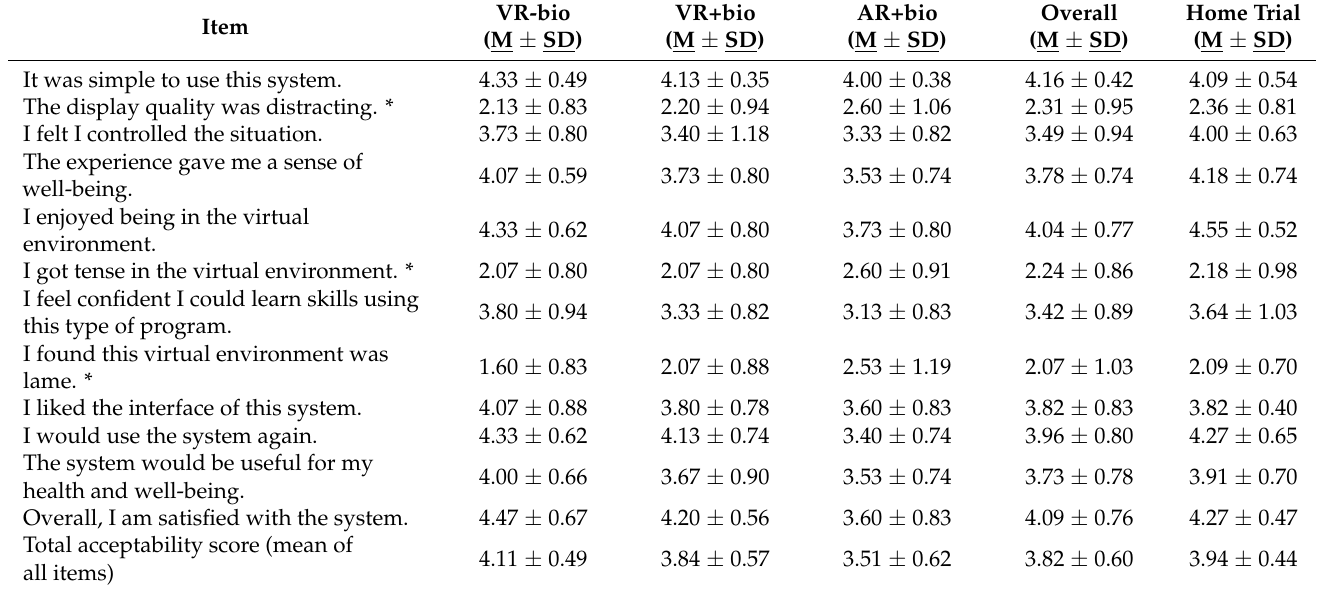
Table 3. Summary of responses to acceptability items during the in-clinic and home experience with XR.